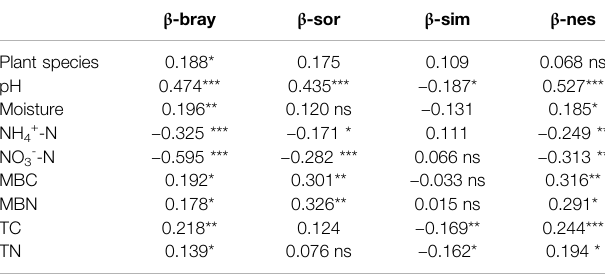
TABLE 1 | Mantel tests for the soil arbuscular mycorrhizal fungi community Bray – Curtis ( β -bray; abundance-weighted), Sørensen ( β -sor; presence/ absence-based), partitioned Simpson ( β -sim), and nestedness ( β -nes) dissimilarities with environmental factor dissimilarities. The Spearman correlation r-valueandsigni fi canteffectsareshown(. p < 0.1;* p ≤ 0.05;** p ≤ 0.01;*** p ≤ 0.001; ns, insigni fi